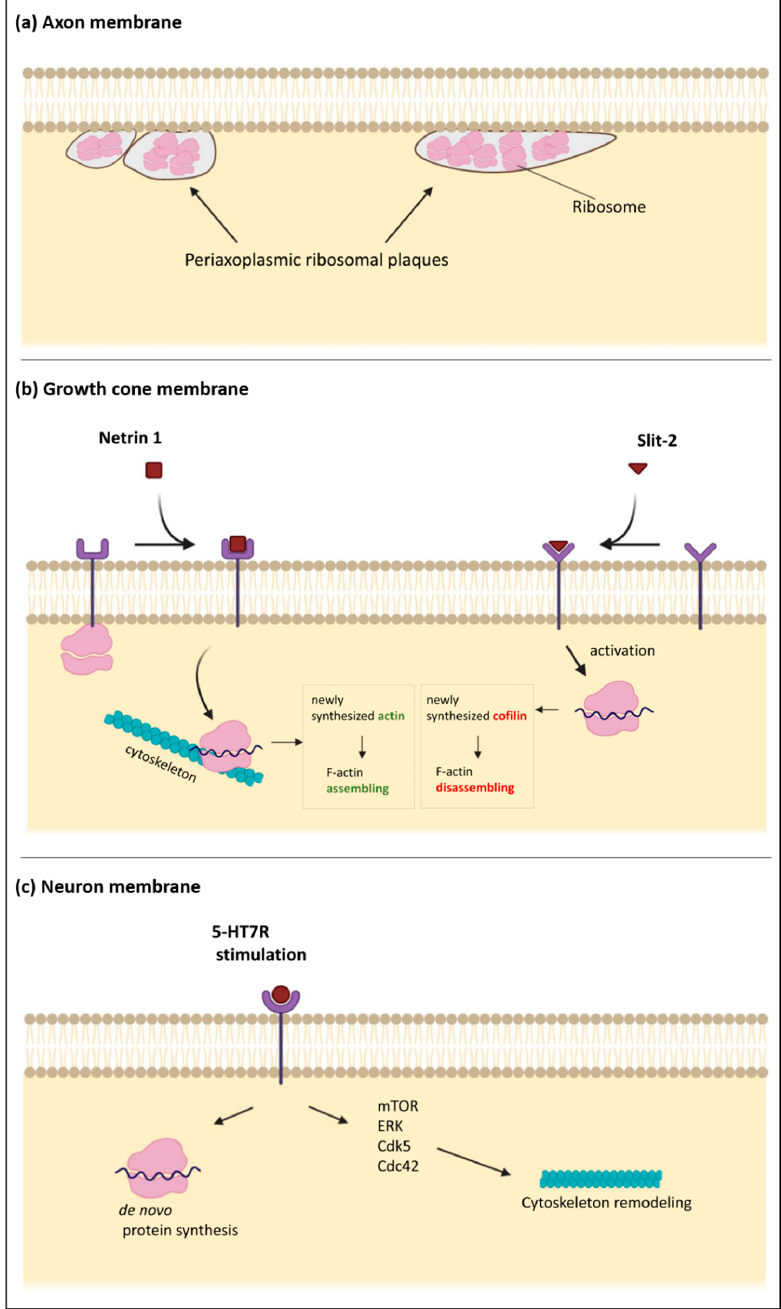
Figure 2. Schematic diagrams of the subplasmalemmal regions in specialized neuronal compartments. ( a ) the axonal plasma membrane is associated with “periaxoplasmic plaques”, which contain ribosomes and therefore serve as a center for intra-axonal protein synthesis. ( b ) The plasma membrane of